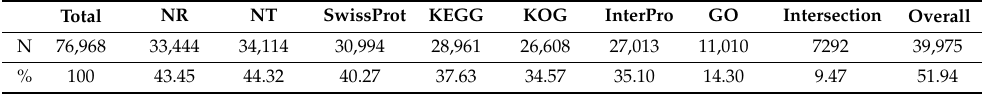
Table 3. Number (N) of transcripts identified in Asymblepharus ladacensis that are shared